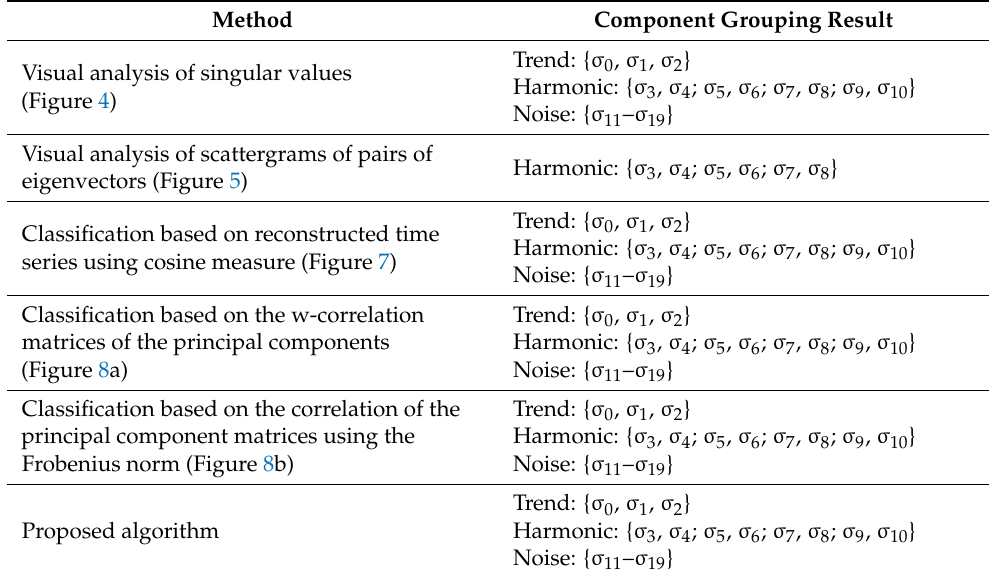
Table 3. Comparison of the results of component grouping by the considered